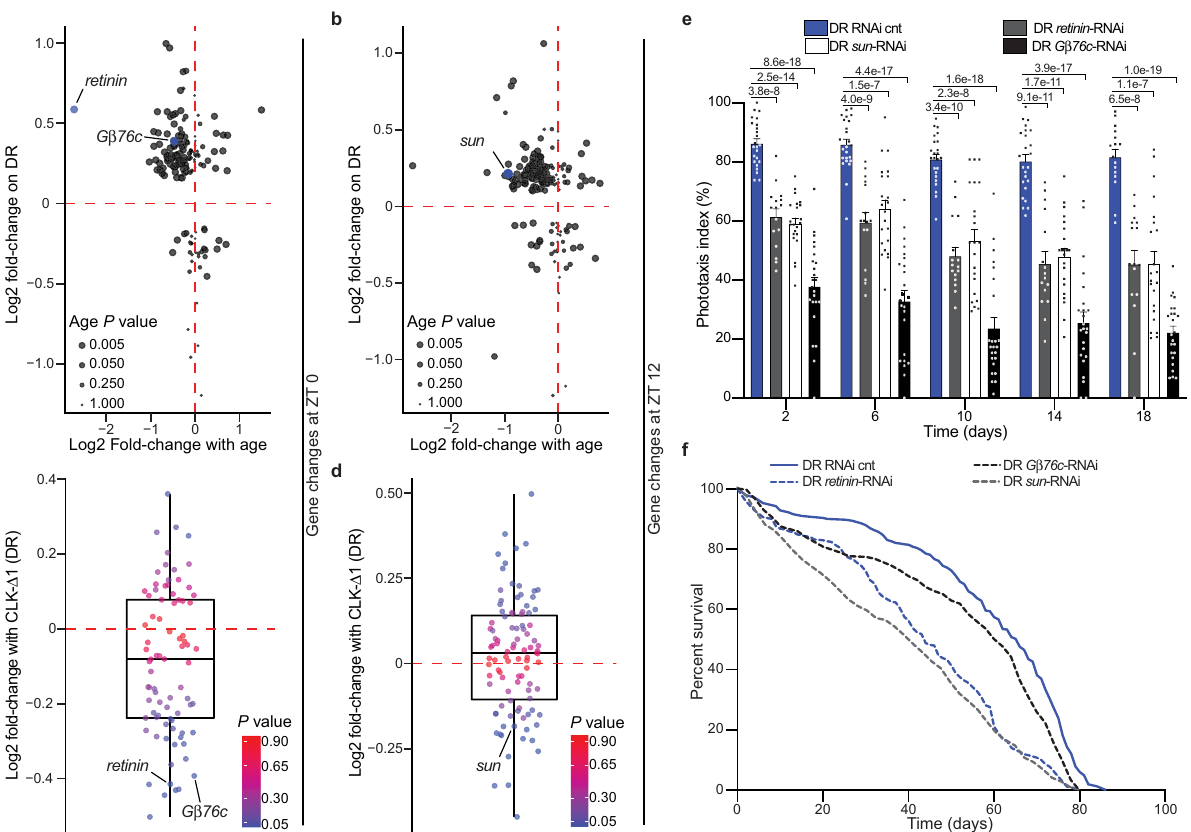
Fig. 6 Knockdown of DR-sensitive, eye-speci fi c CLK-output genes reduces survival. a , b Scatterplot of circadian, photoreceptor-enriched gene changes with age in wild-type heads ( x -axis: 5- vs 55-day old fl ies) vs diet-dependent gene expression changes in heads from nCLK- Δ 1 RNA-Seq control fl ies ( y - axis: DR- vs AL-minus RU486) at ZT 0 ( a ) and ZT 12 ( b ). Age P -values (non-adjusted) were originally reported in ref. 16 and were calculated with Cuffdiff comparing transcript expression at day 5 to day 55 in wild-type Canton-S heads. c , d Boxplots of the expression changes in nCLK- Δ 1 heads (DR plus- vs DR minus-RU486) at ZT 0 ( c ) and ZT 12 ( d ) of genes that were downregulated with age and upregulated on DR (upper left quadrants of panels a , b ). The horizontal line within each box is the median, the bottom and top of the box are lower and upper quartiles, and the whiskers are minimum and maximum values. P -values (non-adjusted) were calculated with DESeq2 comparing transcript expression between controls and nCLK- Δ 1 fl ies reared on DR. e Positive phototaxis responses with eye-speci fi c knockdown of G β 76c (GMR-GAL4 > UAS- G β 76c -RNAi), retinin (GMR-GAL4 > UAS- retinin -RNAi), and sun (GMR- GAL4 > UAS- sun -RNAi) compared to RNAi control fl ies (GMR-GAL4 > UAS-mCherry-RNAi) reared on DR. For each timepoint results are represented as